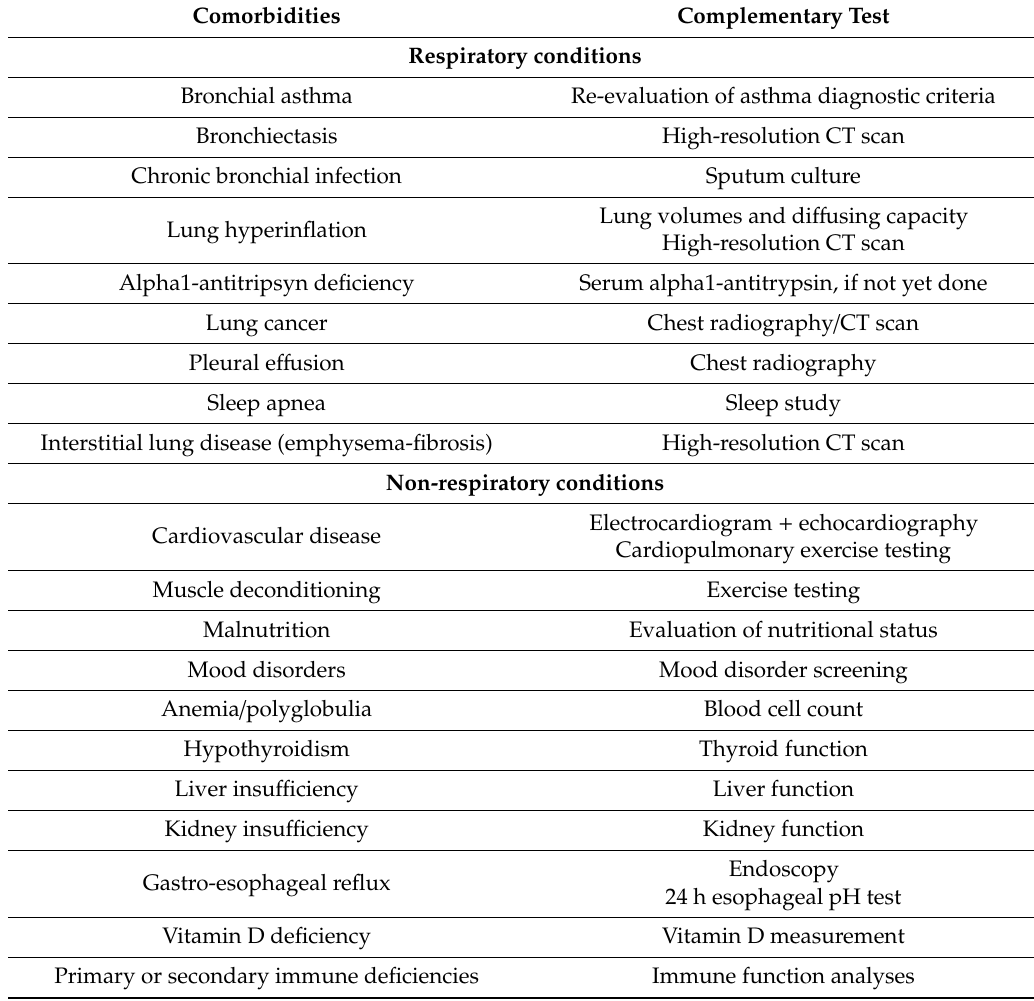
Table 2. List of studies that should be carried out in patients with persistent symptomatic